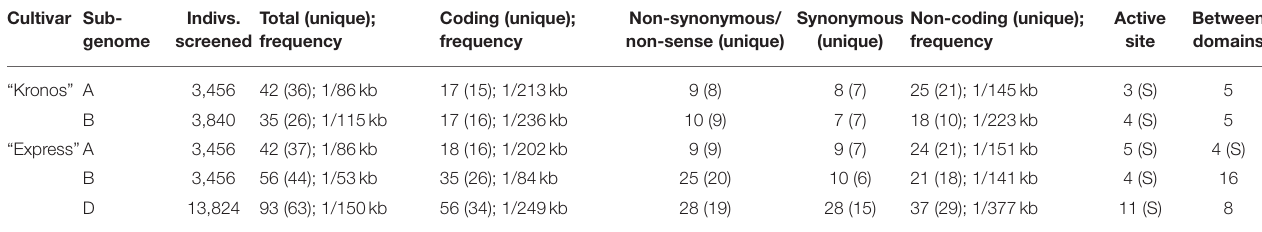
TABLE 1 | Summary of mutations detected in the tetraploid and heaxploid wheat via TILLING. Cultivar Sub- Indivs. Total (unique); genome screened frequency